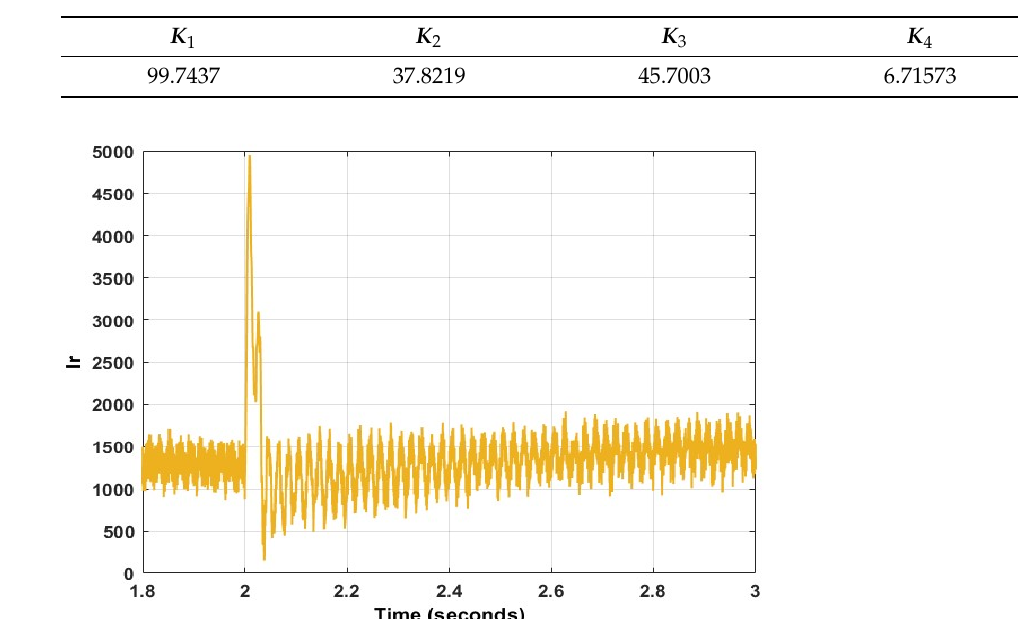
Table 7. LQR controller gains at 80% dip.